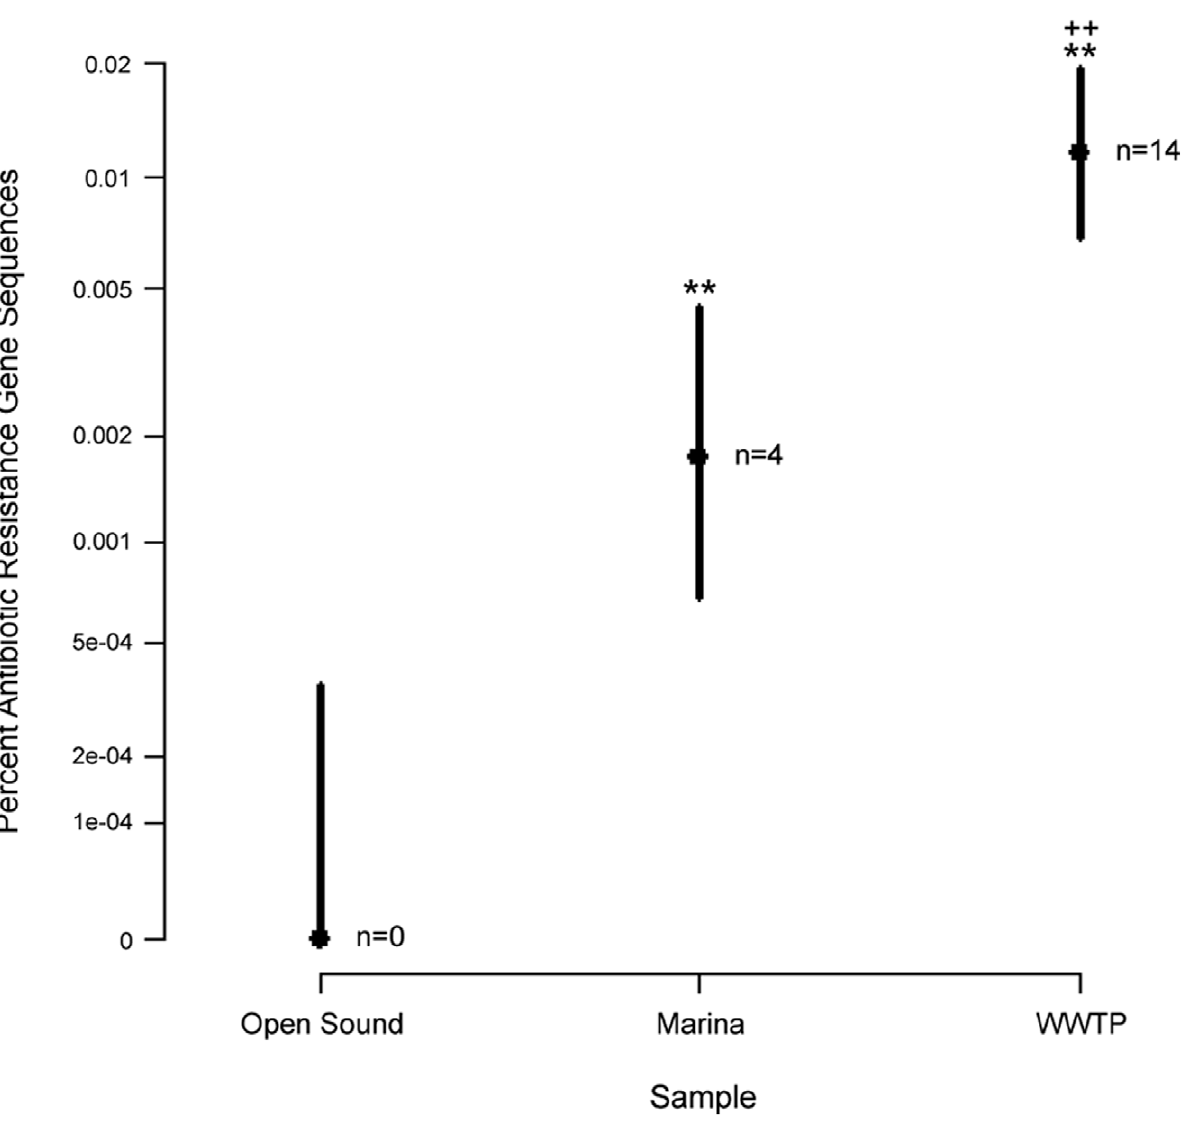
Figure 5. Prevalence of antibiotic resistance gene sequences in the Puget Sound metagenomes. Sequences were classified as antibiotic resistance genes if sharing $ 80% identity and an alignment length $ 50aa to a sequence within an expanded Antibiotic Resistance Genes Database (ARDB) [45]. Open Sound samples were pooled together for the analysis. Bars represent 95% confidence intervals for binomial proportions. For open Sound vs. Marina and WWTP, *p , 0.05 and **p , 0.005. For Marina vs. WWTP, + p , 0.05 and ++ p , 0.005. ‘n=’ refers to the number of antibiotic resistance gene sequences. The y-axis represents a modified log scale. While the resistance gene signals were low for the samples, the signals were significantly different across the sample types, suggesting antibiotic resistance gene abundance may reflect differences in potential human health impacts.